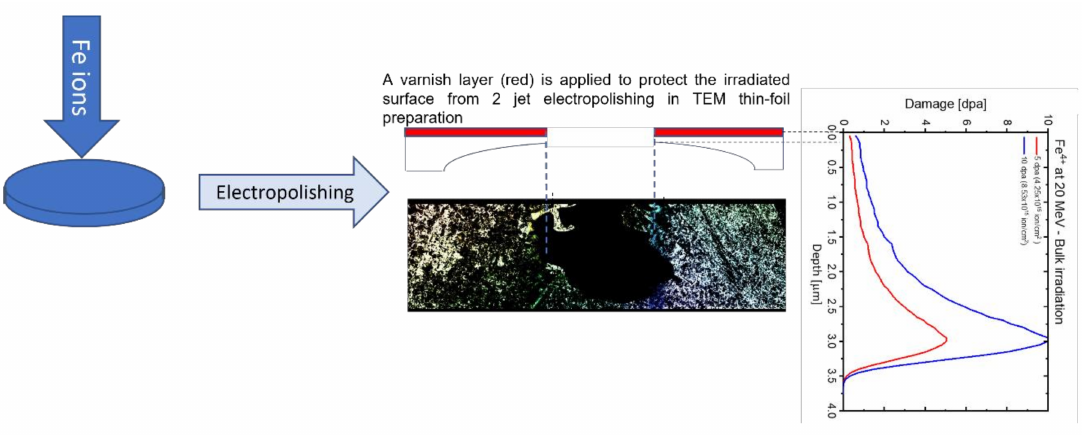
Figure 12. Scheme of electropolished irradiated specimen protected with a varnish.